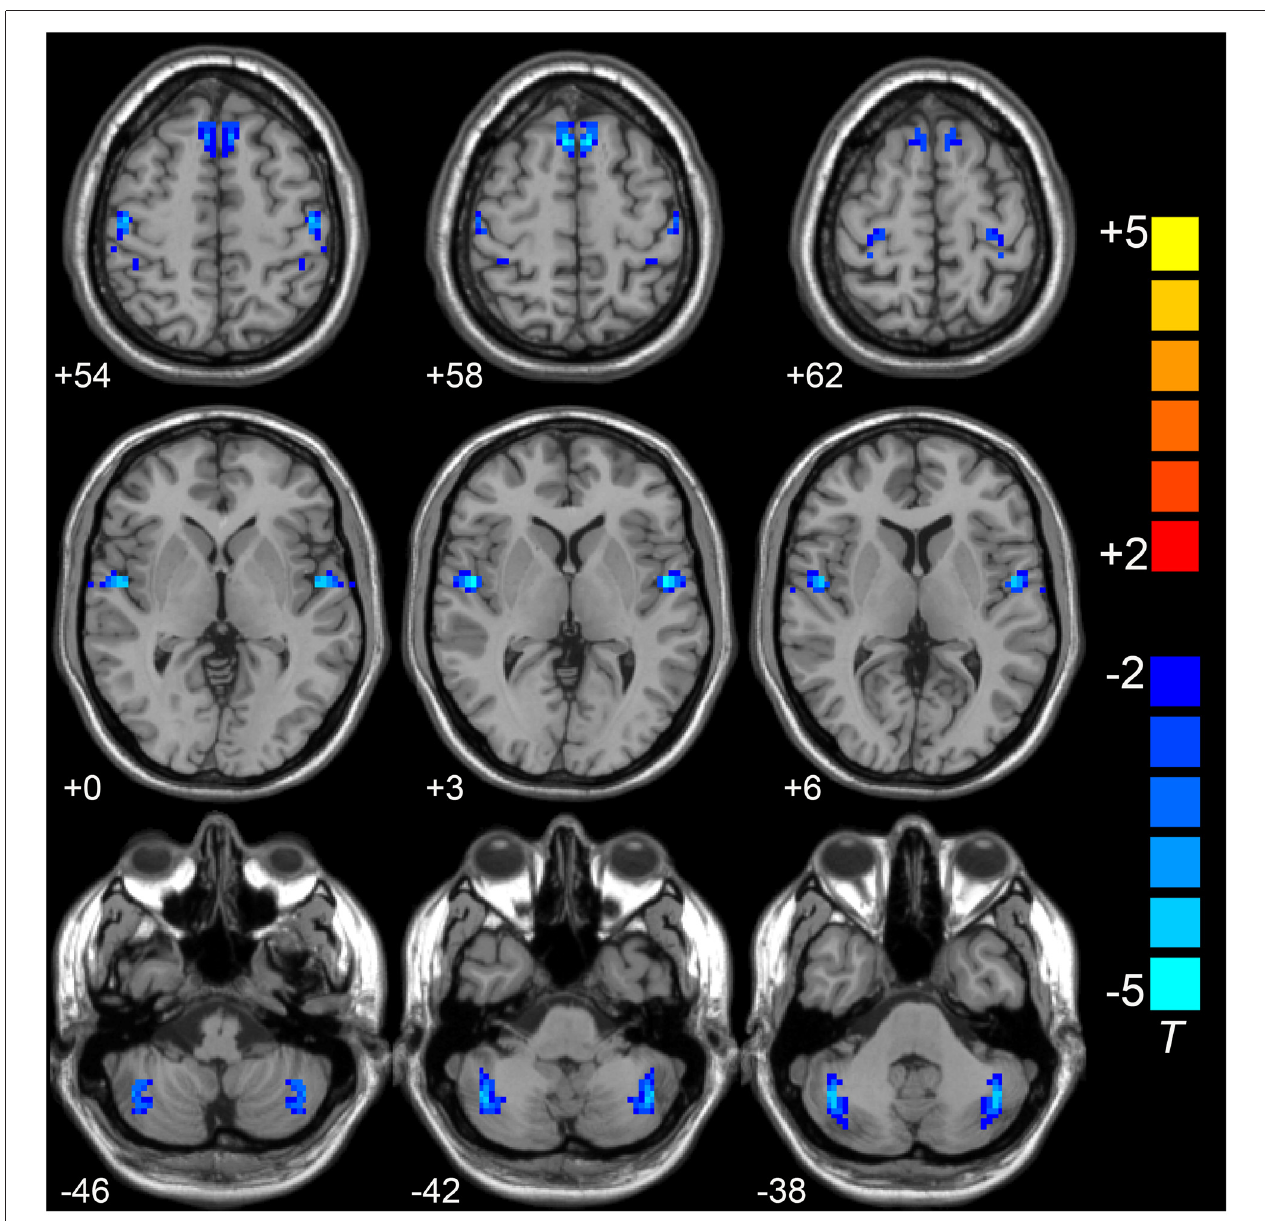
FIGURE 1 | Compared to HCs group,VMHC in superior frontal gyrus (SFG), superior temporal gyrus (STG), posterior cerebellar lobe (CePL), postcentral and precentral gyri was observed in LOD. Blue color represents reduced VMHC value in LOD. The numbers at the down left of each image refer to the z-coordinates in Montreal Neurological Institute template. The threshold was set at a corrected P < 0.001 (corrected with P < 0.01 for each voxel and cluster volume ≥ 55 voxels) and the t -score bar is present at the right-side. Notes: HCs, Healthy Controls; VMHC, Voxel-Mirrored Homotopic Connectivity; LOD, Late-Onset